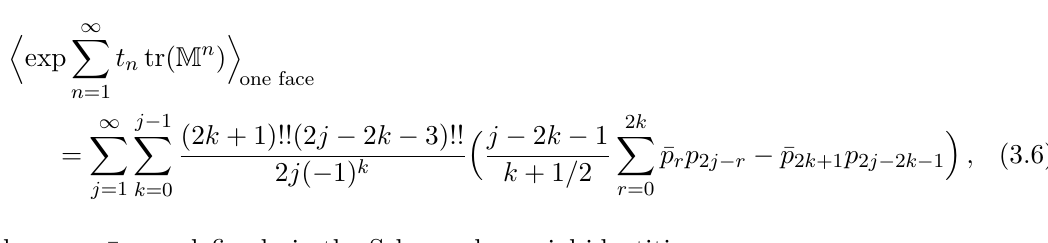
Figure 10 . (a) Splitting and (b) joining of traces representend as di(cid:11)erential operators in (3.8). function of all these multi-trace Hermitian matrix model single-face expectation values